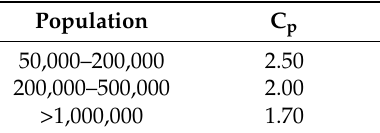
Table 4. Peak flow factor